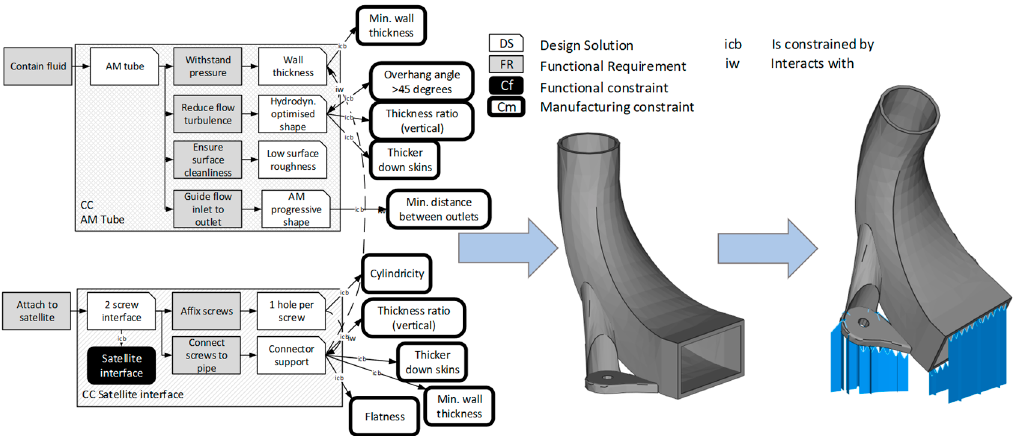
Figure 4. Propellant flow connector redesigned for AM presenting the preferred build orientation and